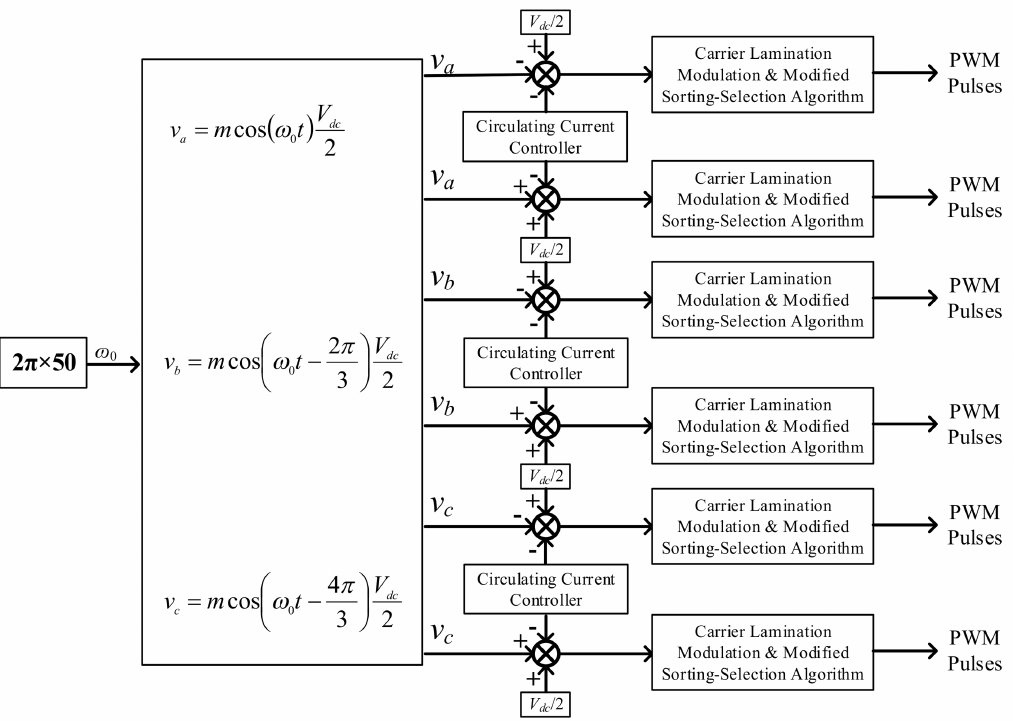
Figure 5. The control system block